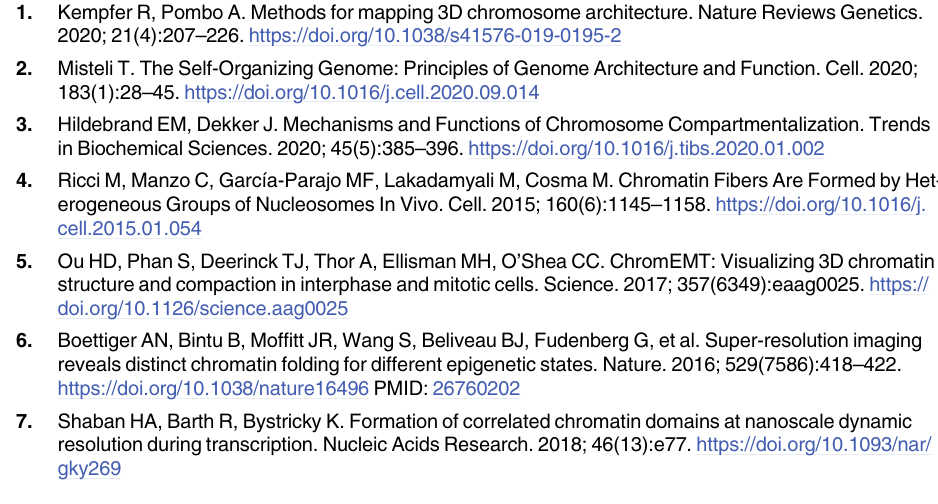
S4 Fig. Fitting of multiplicative cascades to simulated euchromatin distributions repro- duces correlations seen in fitting DNA image data. Synthetic image data from microemulsion simulations of euchromatin organization were used to verify the correlation of multiplicative cascade parameters with image contrast. Simulations for a microemulsified state of euchroma- tin (untreated case, 120 simulations), a well-mixed state of euchromatin (no transcription, 45 simulations), and the phase-separating case (flavopiridol treatment, 154 simulations) from our previous work were pooled [16]. Image generation parameters for microemulsion simulations: 100-by-100 simulation lattice, pixel size 100 nm, σ = 200 nm, λ = 0.5, σ = 50 nm, central 1 2 32-by-32 pixel region of image used in mass distribution calculation. Image generation parame- ters for cascade fitting: 32-by-32 pixel images generated by four cascade recursions, pixel size 100 nm, σ = 200 nm, λ = 0.4, σ = 50 nm. Gray circles are medians of the top-100 parameter 1 2 sets (evaluated based on variance, skewness, kurtosis comparison). Linear fits (red line) are shown. The Pearson correlation coefficient ( ρ ) and the p value for the particular values of ρ are indicated for each cascade